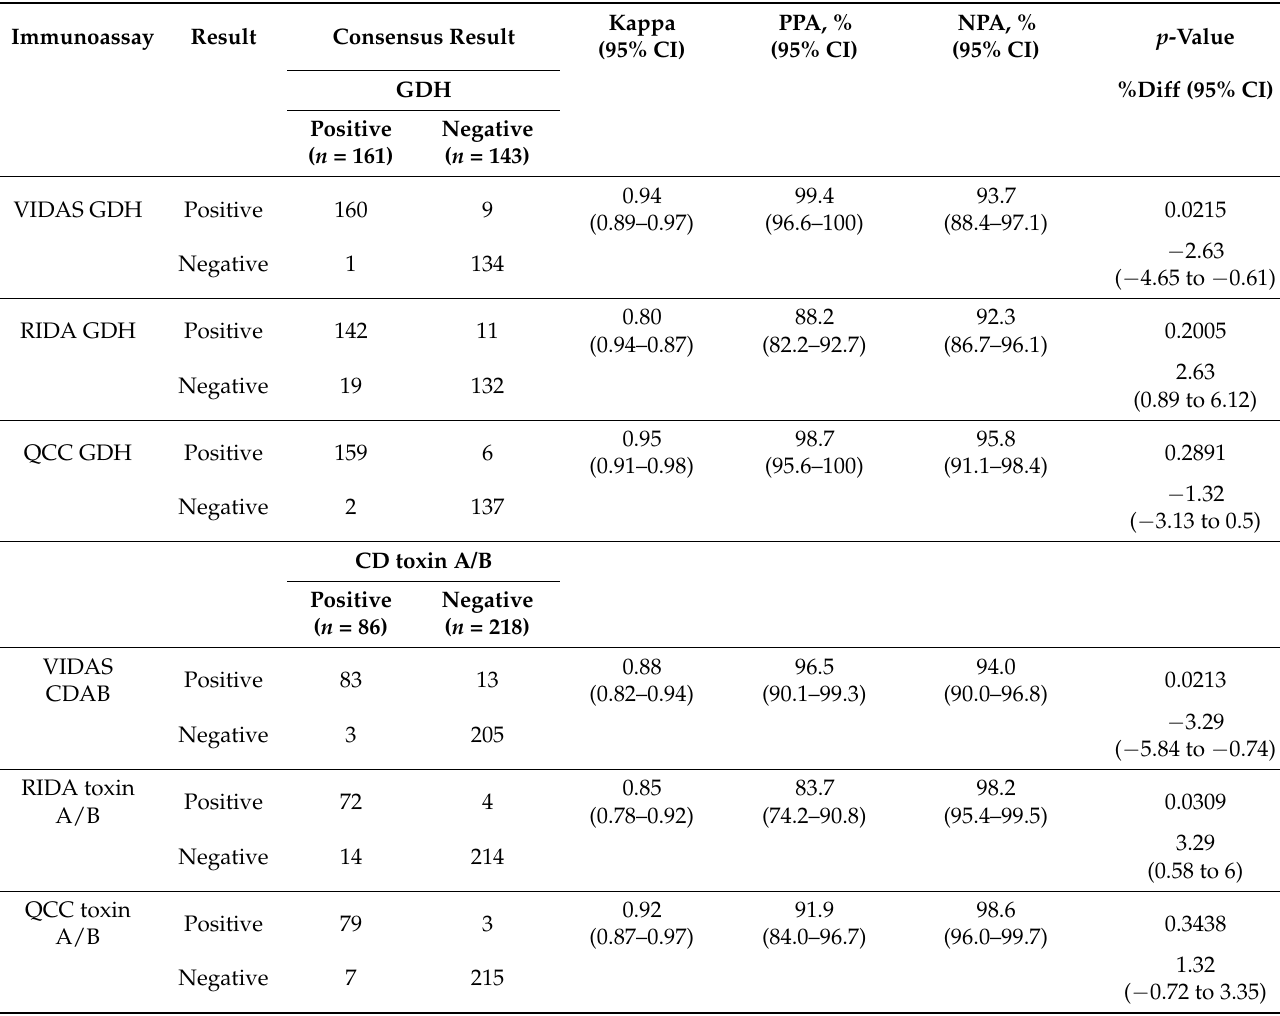
Table 4. Consensus results of assay agreement among the three immunoassays for the detection of Clostridioides difficile glutamate dehydrogenase and toxin